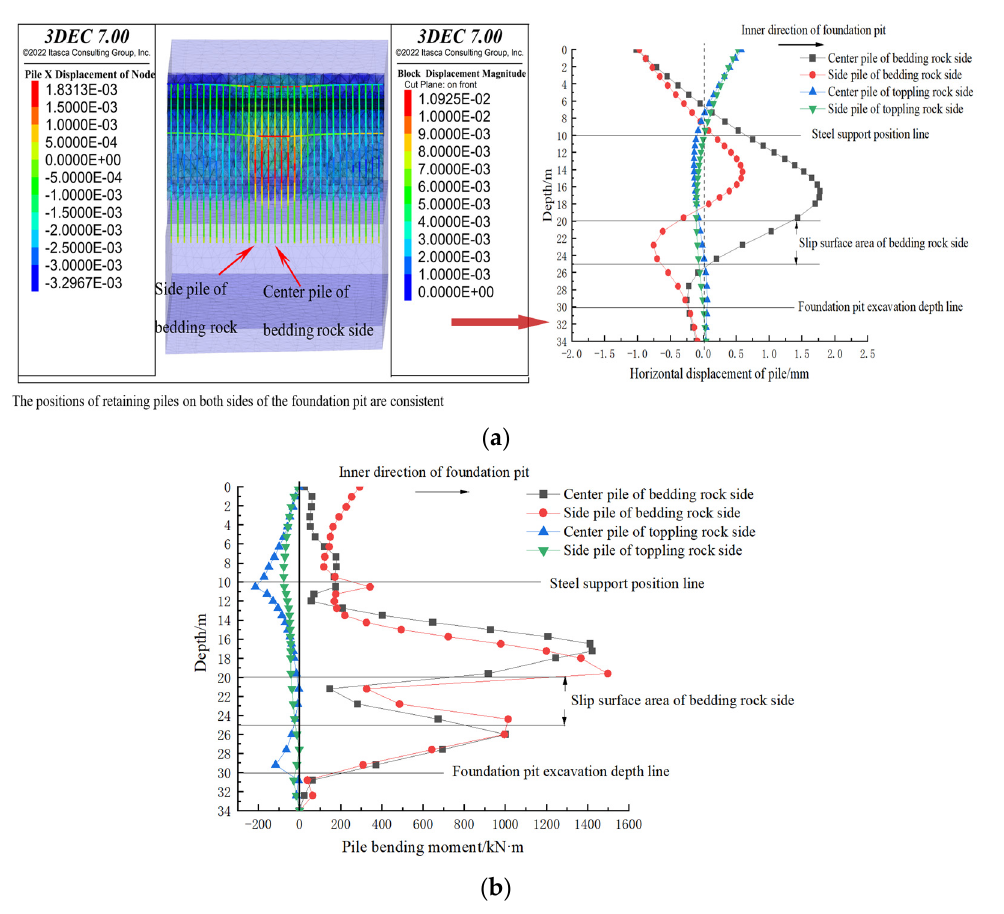
Figure 11. Stress analysis of pile-bracing support with 1.5 times pile spacing (pile body analysis). ( a ) displacement diagram of the pile; ( b ) bending moment diagram of the pile.